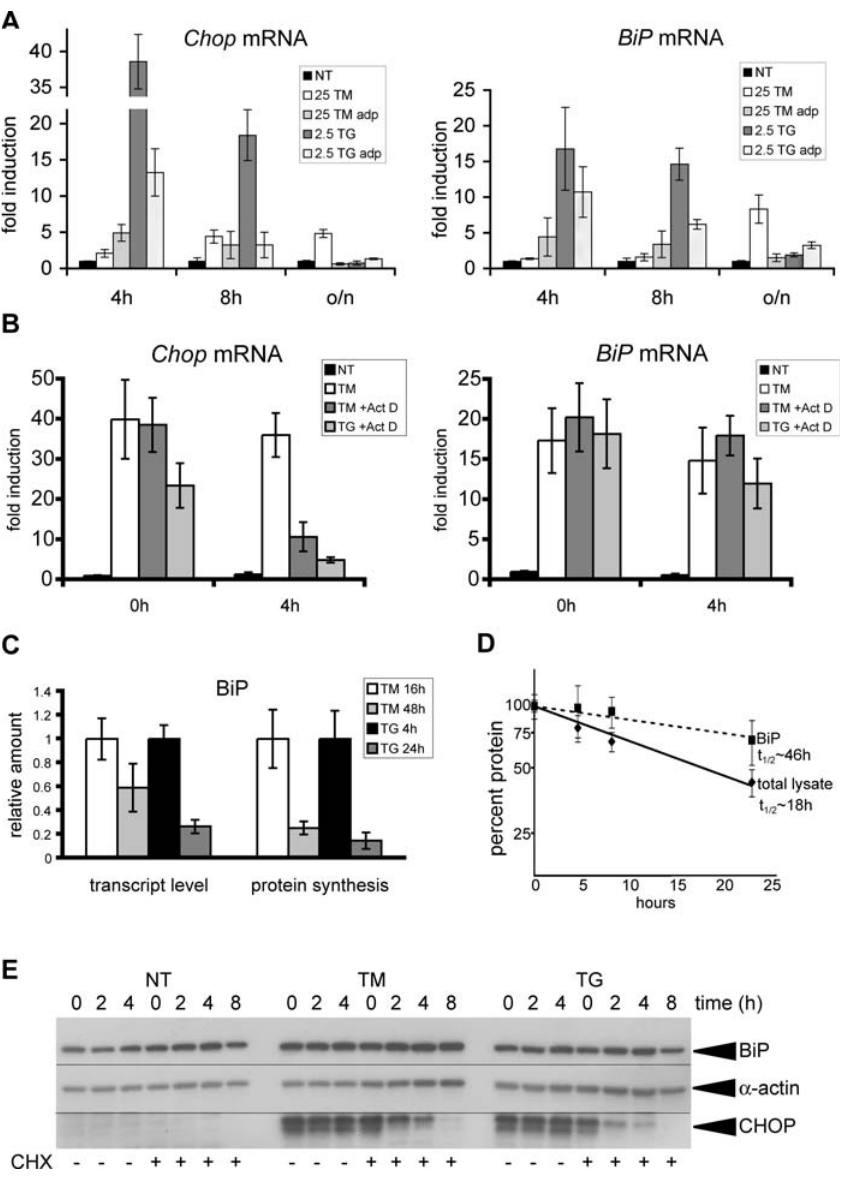
Figure 5. Pro-apoptotic mRNAs and Proteins Are Selectively Unstable (A) Naive or adapted (adp) cells were treated, or retreated, with TM or TG. After 4, 8, or 24 h of stress (for naive cells) or media re-addition (for adapted cells), total RNA was isolated and the expression of BiP and Chop was quantitated by real-time RT-PCR, normalizing against 18S rRNA expression. Error bars represent means 6 SDM from RNA isolated from three independent plates. (B) MEFs were treated with 25-ng/ml TM overnight or 2.5-nM TG for 4 h, and actinomycin D (Act D) was added as indicated to a final concentration of 5 l g/ml to prevent new mRNA synthesis. RNA was then harvested at 0 or 4-h time points ( ‘‘ time 0 ’’ followed 15 min of actinomycin treatment to allow for full effect), and expression of Chop and BiP mRNAs was measured by real-time RT-PCR as in (A). Error bars represent means 6 SDM from replicate PCR reactions of a single experiment. (C) MEFs were grown for 48 h in media containing 10% of the normal amount of methionine and cysteine, and were treated either for the full 48 h or just the last 16 h with 25-ng/ml TG (or alternatively, cells were treated for 24 or 4 h with 2.5 nM TG). After treatment, three plates were immediately processed to harvest mRNA, and to the remaining three plates, 35 S methionine/cysteine was added to a final concentration of 200 l Ci/ml for 30 min, followed by cell lysis. Expression of BiP mRNA was assessed by real-time RT-PCR ( ‘‘ transcript level ’’ ), whereas the synthesis rate of BiP was measured by immunoprecipitation with an antibody recognizing the KDEL ER retention motif. SDS-PAGE and autoradiography revealed BiP expression, which was then normalized against TCA-precipitable counts from the immunoprecipitate supernatants, as a measure of total radioactivity input. Error bars are SDMs derived from independent readings of mRNA and protein synthesis from three plates each. (D) Untreated cells were subjected to steady-state labeling overnight with 35 S Met/Cys. Cells were then chased in non-radioactive media containing excess methionine and cysteine, and either vehicle alone or 25-ng/ml TM for 0, 4, 8, or 24 h. The amount of radioactivity in the lysates was determined by TCA precipitation of aliquots, and was normalized against total protein concentration, whereas the amount of labeled BiP was assessed by immunoprecipitation. At each time point, three independent plates were harvested. The presence or absence of TM during the chase period did not significantly affect the measured half-life of either BiP or the lysate as a whole; therefore, each point represents input from replicate plates in both conditions. (E) MEFs were pretreated either for 4 h with 2.5 nM TG or overnight with 25 ng/ml TM to induce expression of CHOP. Cycloheximide (CHX) was then